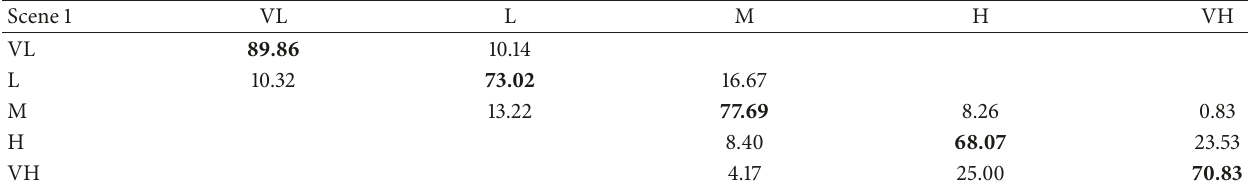
Table 3: The classification accuracy of global method